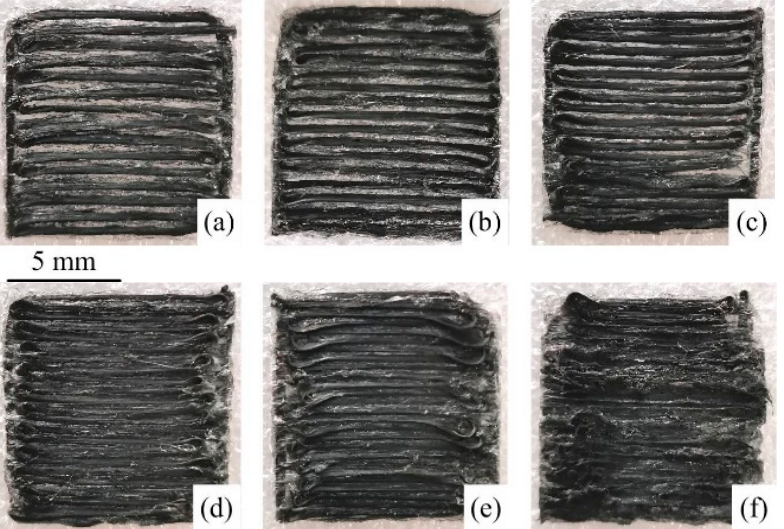
Figure 7. Surface morphology of monolayer composites with different path overlap rates. ( a ) 10%; ( b ) 20%; ( c ) 30%; ( d ) 40%; ( e ) 50%; ( f ) 60%.It is obvious that when the path bonding rate was 10%, 20% and 30%, as shown in Figure 7a~c, an overlap between the two deposited single paths could not be perfectly achieved and there were obvious gaps between the paths; when the path bonding rate was 40%, as shown in Figure 7d, the gaps between the deposited paths were filled and the surface quality of the monolayer composite was also good; when the path bonding rate was 50% and 60%, as shown in Figure 7d,e, an excessive amount of composite material accumulated and formed bumps in the overlap area, and the movement of the nozzle formed scratches on the bumps, resulting in poor surface quality of the monolayer composite. Under the experimental conditions of this work, the optimal path lap ratio was 40%.